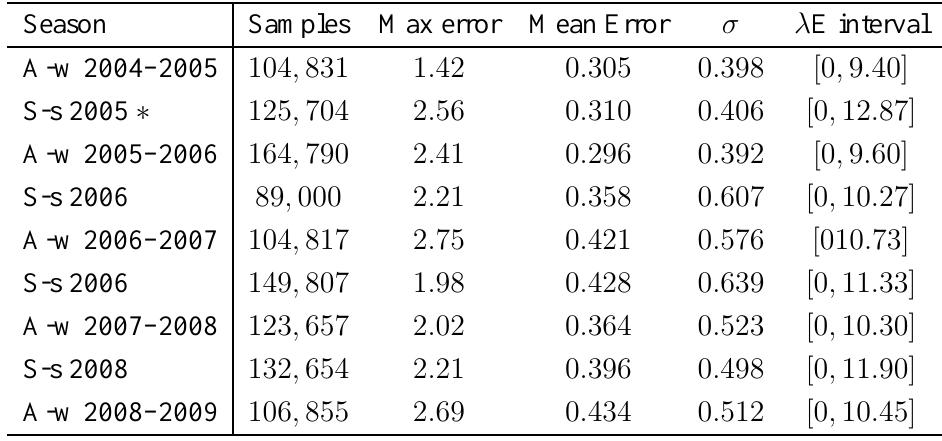
Table 6. Empirical (black-box) virtual sensors error calculation in g m − 2 min − 1 .